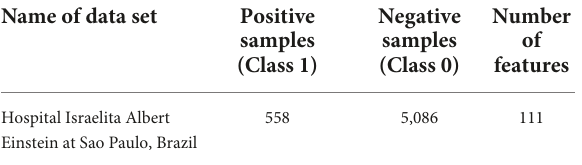
TABLE 1 Dataset description. TABLE 2 Features selected after applying distributed decision